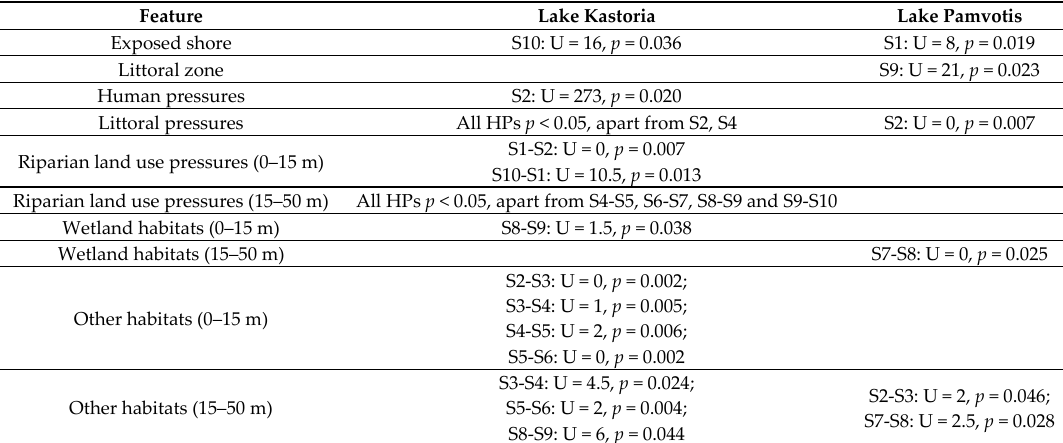
Figure 2. ( a ) The percentage of entries for each section of the LHS survey that were matching between the foot-based approach and satellite imagery approaches in each lake; ( b ) Comparison of the average number of recorded features observed between the two approaches (foot-based approach and satellite imagery) per section. Table 1. Significant differences between approaches (foot-based approach and satellite imagery) according to Mann-Whitney U test. HP: Habitat Plot, S: